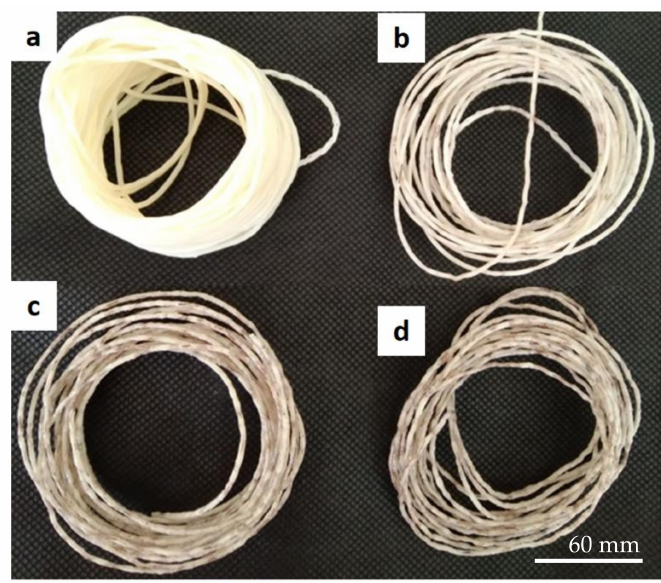
Figure 6. The rheology test samples: ( a ) 0 wt%, ( b ) 3 wt%, ( c ) 5 wt%, and ( d ) 7 wt% of oil palm fiber composite at a 240 ◦ C die